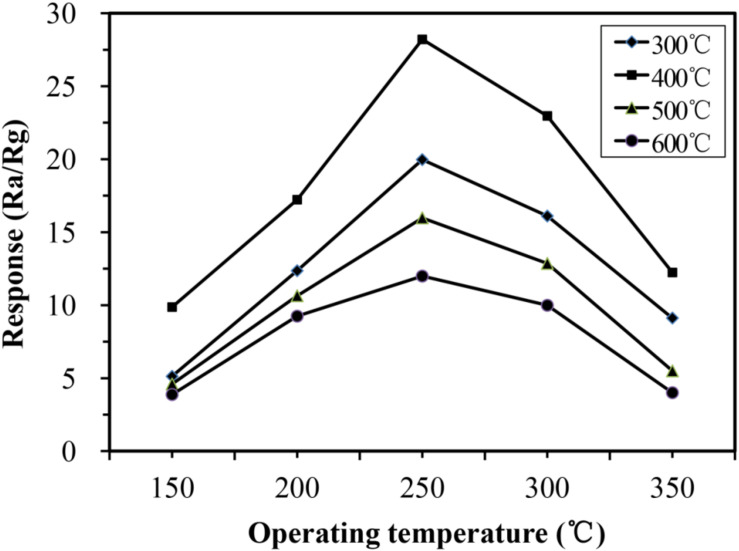
Responses of α-Fe2O3-300, α-Fe2O3-400, α-Fe2O3-500, and α-Fe2O3-600 sensor to 100 ppm trimethylamine (TMA) at different temperatures.